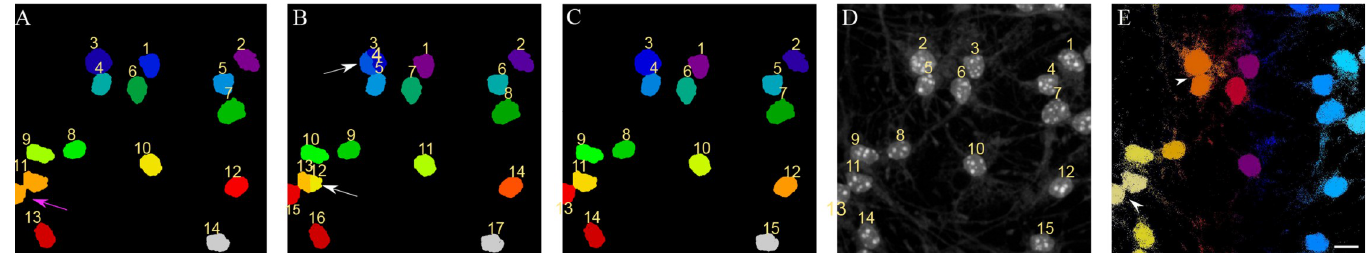
Fig 3. Use of minimum depth and correction in segmentation. (A) Segmentation of nuclei is performed with starfish ’s default settings. Magenta arrow designates undersegmentation, or multiple nuclei erroneously merged together. No minimum depth was used. (B) Minimum depth of 10 − 5 is used to artificially oversegment the previously undersegmented nuclei. White arrow designates oversegmented nuclei. (C) Oversegmentation can easily be corrected using the new segmentation correcting function. (D) The original nuclei image, which accurately resembles the final nuclei segmentation. (E) Outline of nuclear by FISH-quant. Entire image was seleted for autodetection. Empty arrows are pointing to the under-segmented nuclear that need to be separated manually. The scale bar is 10 μ m.